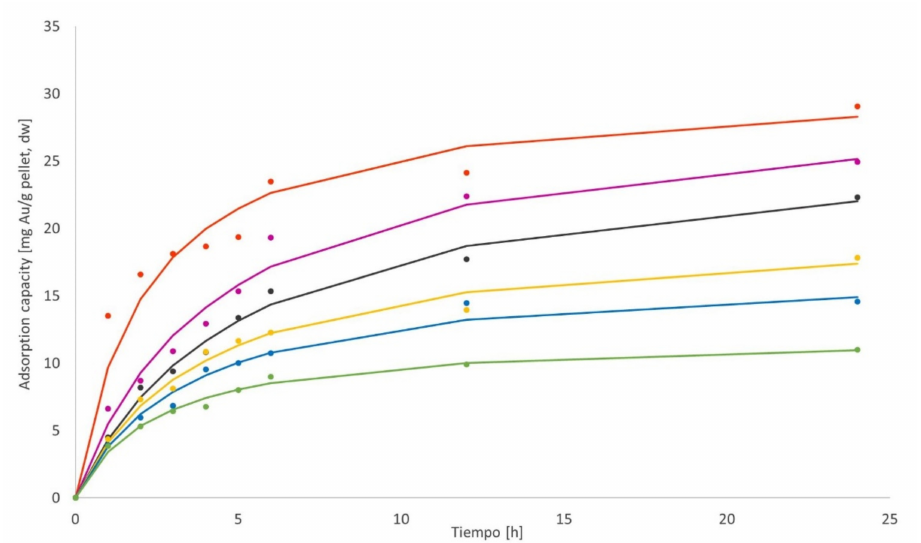
Figure 17. Au adsorbed on different quantities (dry weight) of Cladosporium cladosporioides pellets.